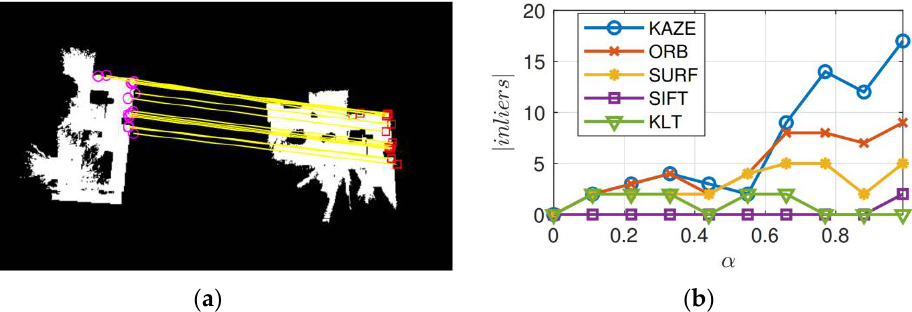
Figure 8. Geometrically consistent MSAC inliers across two occupancy maps. ( a ) Location of KAZE inliers in the processed obstacle-free layer with threshold α = 0.99, ( b ) Number of geometrically consistent features computed for KAZE, ORB, SURF, SIFT, and KLT methods.